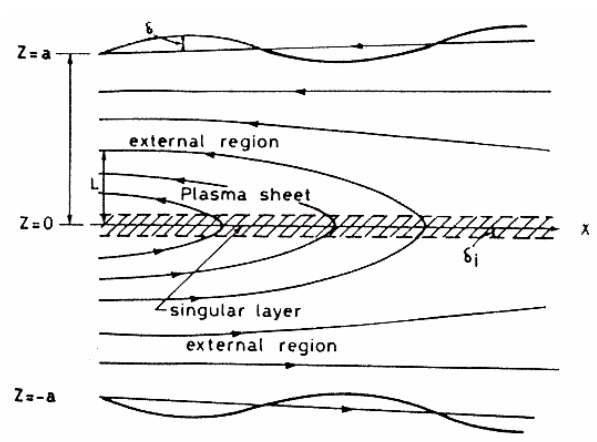
Fig. 1. Schematics of the Earth’s magnetotail: The magnetotail has a characteristic dimension of 2 L in the z -direction. The magne- topause is perturbed by δ due to its interaction with the solar wind. The z = 0 is the layer of singularity and has a width of twice the ion-Larmor